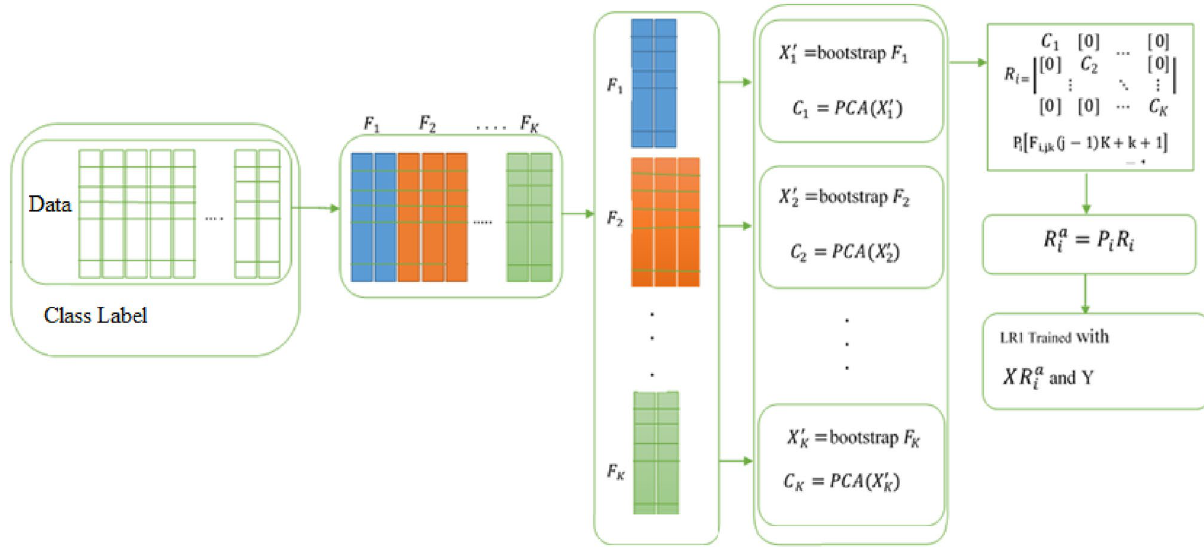
Figure 3. Rotation forest 51